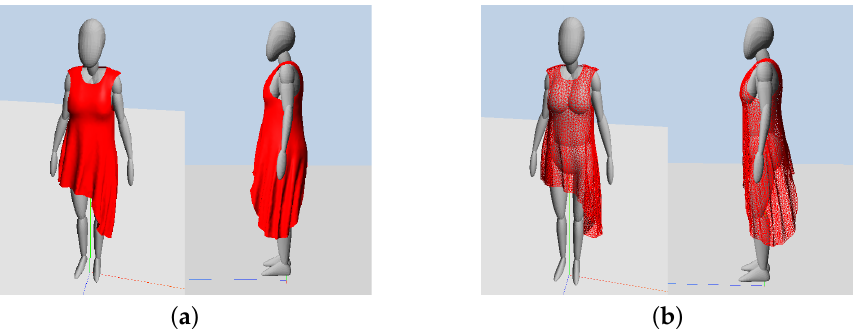
Figure 21. Interaction simulation of Slim Tall model and garment using cushion model and showing rigid-body vs. soft-body interaction. Visualization: Constructed by us in Three.js [41]. Simulation: Constructed by us in Ammo.js [5]. ( a ) Solid-color garment. ( b ) Wireframe garment.